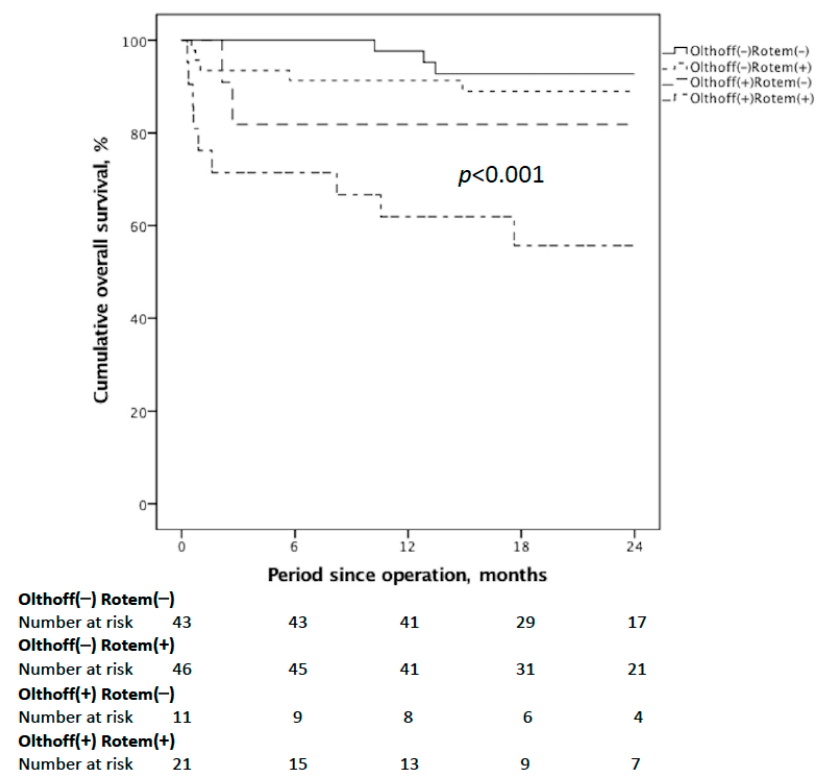
Figure 1. OS according to the development of EAD. Post-transplant 1-year/2-year OS were inferior in the EAD group than the non-EAD group ( p = 0.001). Table 2. Post-operative outcomes of the patients after LDLT according to development of EAD or not.